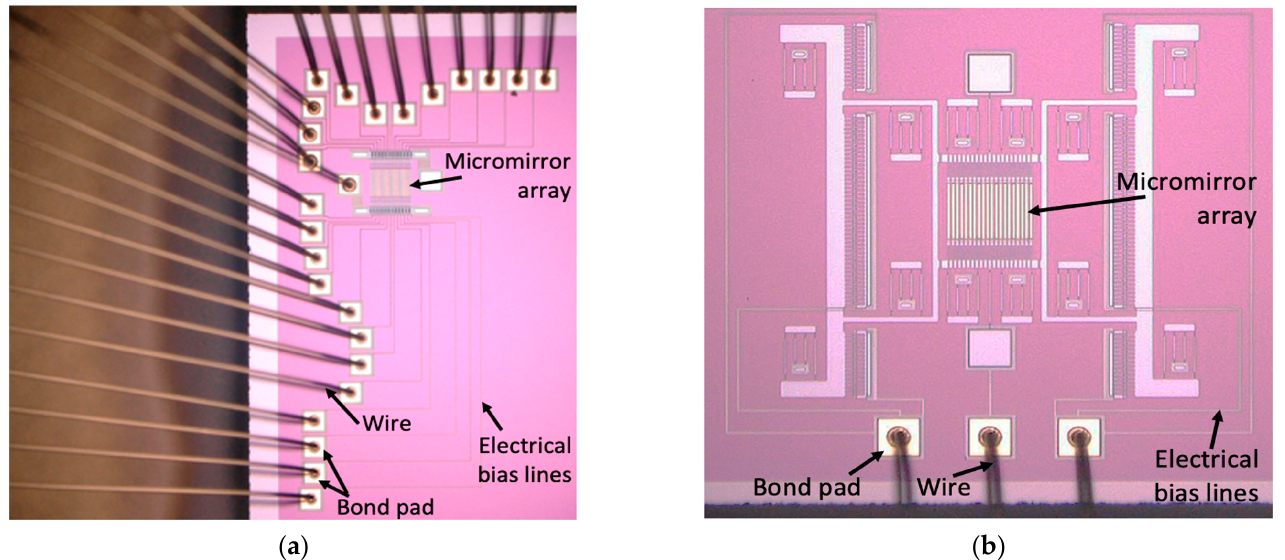
Figure 5. Microscopic images showing ball-stitch wire bonding used for ( a ) piston-motion micromirror-based OPA; ( b ) pitch-tunable micromirror-based OPA.